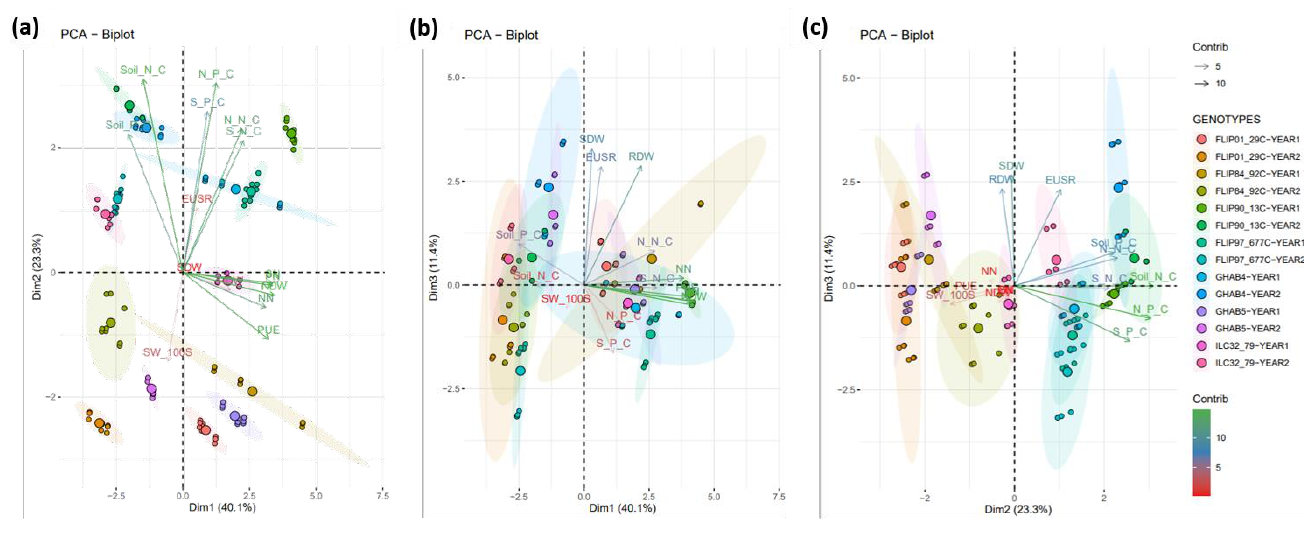
Figure 3. Principal component analysis of fifteen plant functional traits for seven chickpea genotypes grown under a phosphorus deficiency soil, during two growing seasons. ( a – c ) panels correspond to the biplots of different combinations of the three first dimensions. The graph was obtained using the fviz_pca_biplot function of the factoextra package of the R software. NDW, RDW, SDW, nodule, root and shoot dry weight; NN, PN, SN, nodule, pod, and seed number; SW_100S, 100 seed weight, PUE, phosphorus use efficiency and EURS, efficiency in use of the rhizobial symbiosis; N_P_C, S_P_C, Soil_P_C, N_N_C, S_N_C and Soil_N_C, nodule, shoot and soil P and N content, respectively.